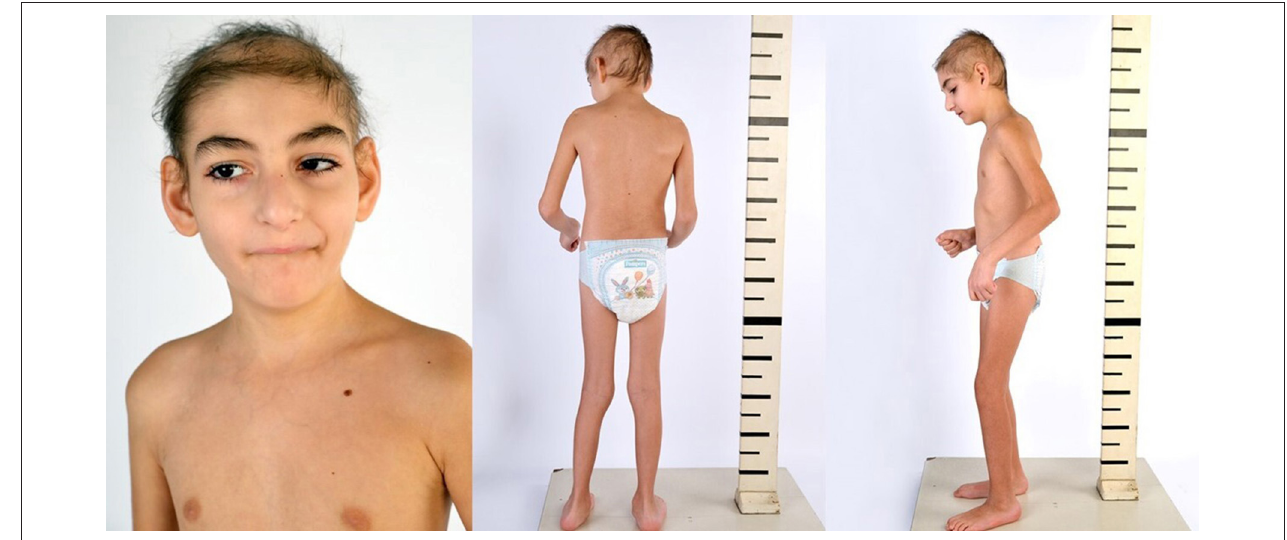
FIGURE 4 | Eight years old.